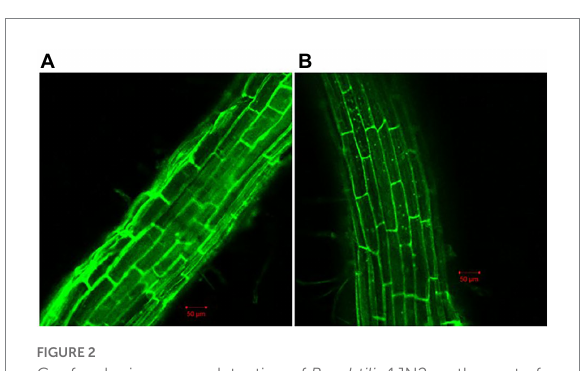
FIGURE 2 Confocal microscope detection of B. subtilis 1JN2 on the root of tomato with (B) or without (A) Cd2 + treatment. Fluorescent analysis was carried out using ZEISS LSM 700. GFP was selected in Smart Setup, the excitation wavelength is 488 nm, and the emission wavelength is 493–550